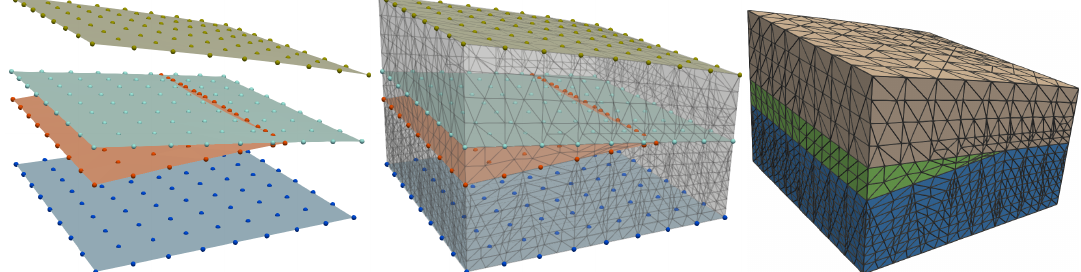
Figure 9. A sketch of the pipeline to build the geological model and the mesh. On the left we show the point cloud and corresponding reconstruction of the horizons. In the middle we show the lateral surfaces together with the internal horizon. On the right we report the final Computational grid of the geological